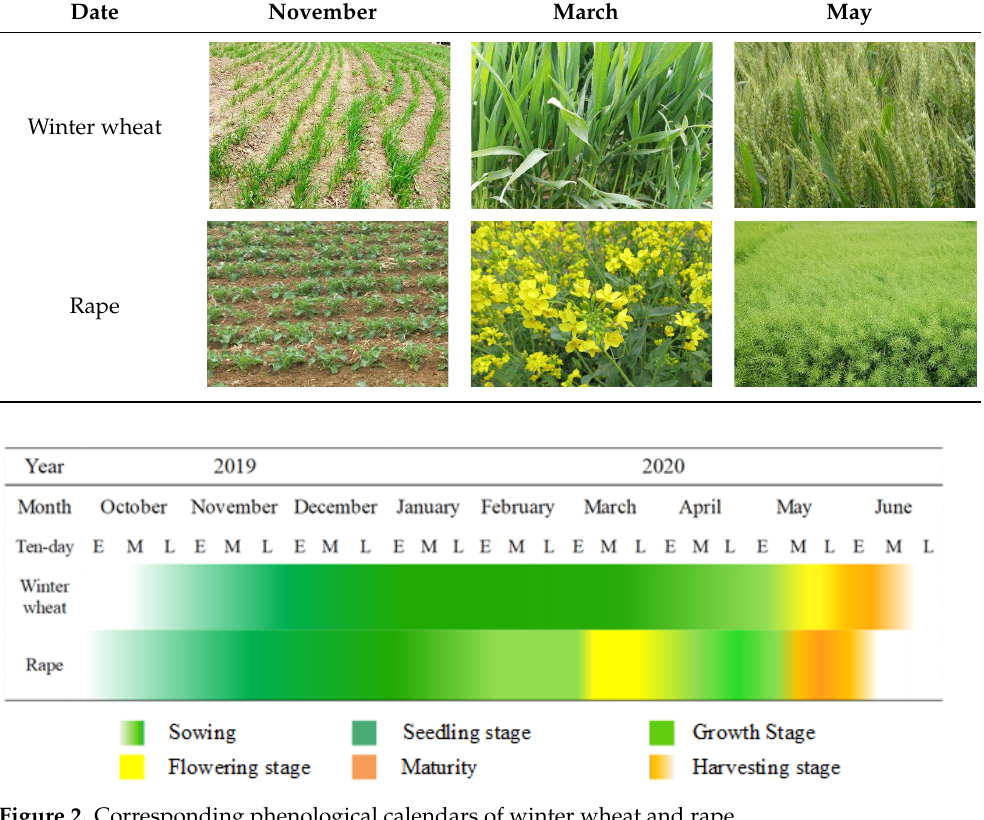
Table 1. Actual conditions of winter wheat and rape growth cycles.